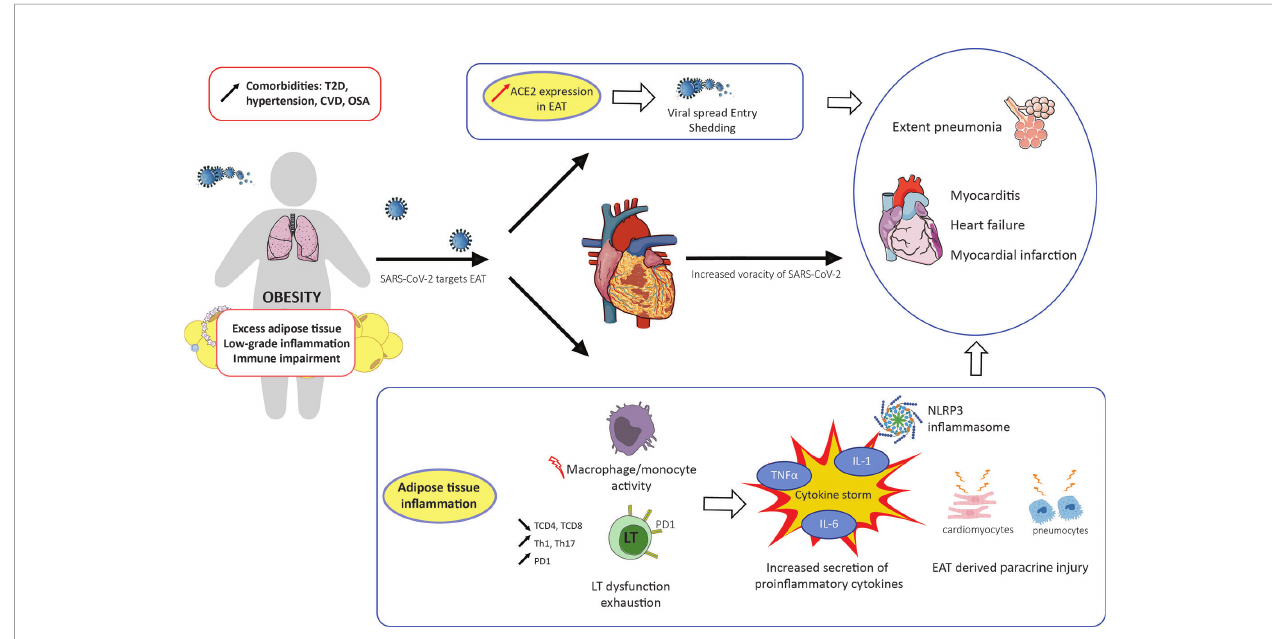
FIGURE 1 | Impact of obesity and in fl ammation of epicardial adipose tissue on COVID-19 outcome. CVD, cardiovascular disease; EAT, epicardial adipose tissue; OSA, obstructive sleep apnea; T2D, type 2